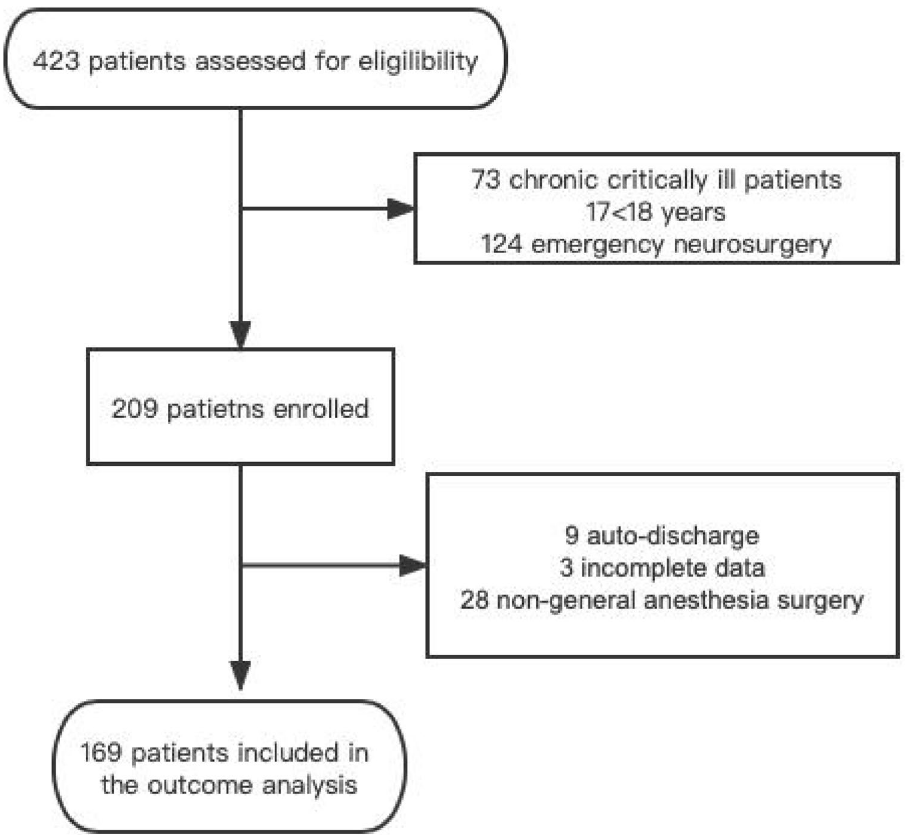
Figure 1. Flow of participants through the